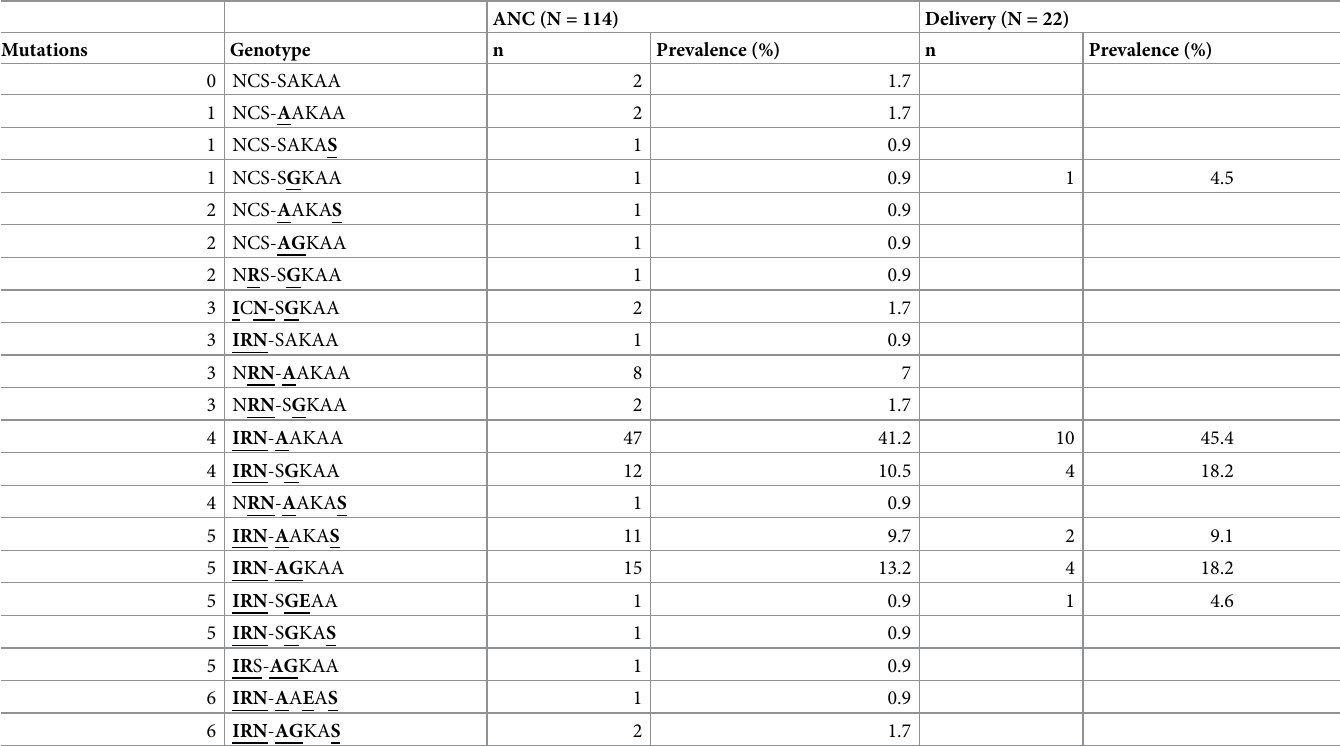
Table 4. Prevalence of combined Pfdhfr (codons 51/59/108) and Pfdhps (codons 436/437/540/581/613) haplotypes at first ANC and at